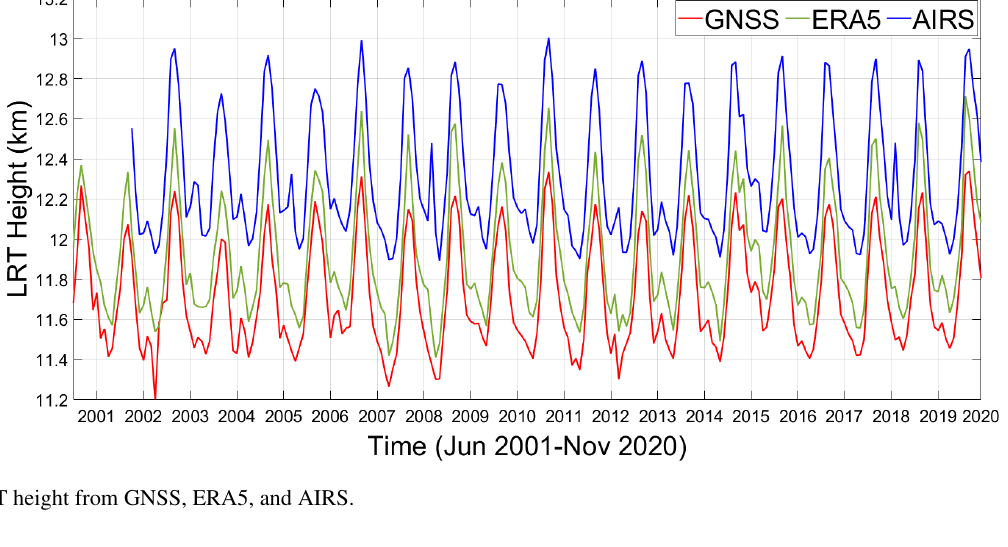
Figure 4. LRT height from GNSS, ERA5, and AIRS.